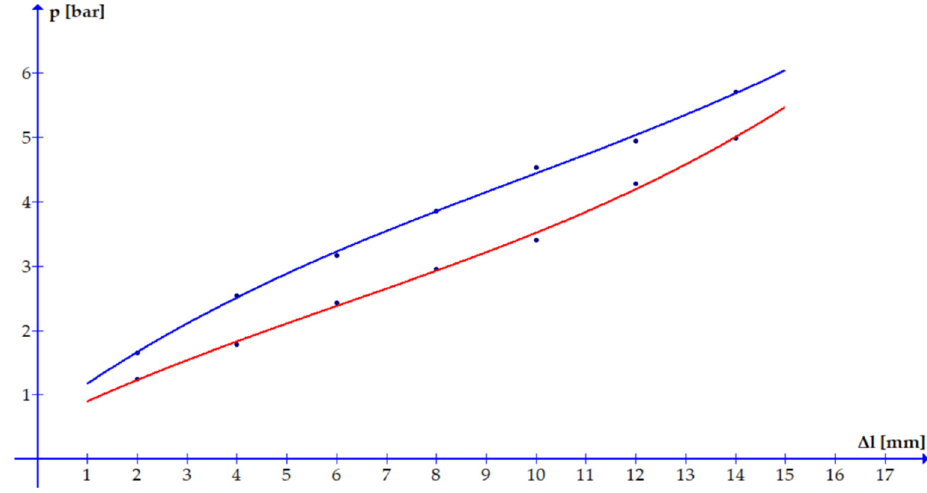
Appl. Sci. 2021 , 11 , 9855 Figure 11. The evolution of the input pressure versus axial contraction (M = 0 kg). Figure 11. The evolution of the input pressure versus axial contraction ( M = 0 kg).